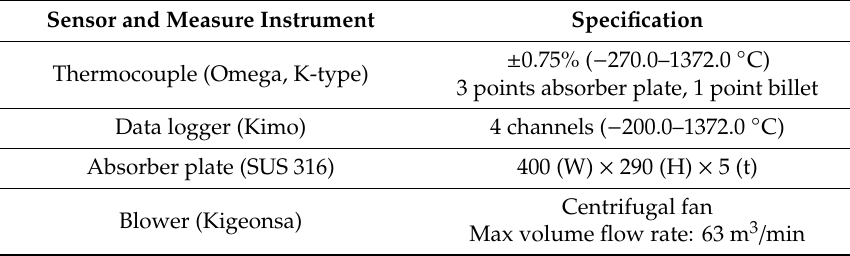
Figure 2. Schematic diagram of the experimental apparatus for analysis verification. Table 1. Specifications of the experimental apparatus for analysis verification.